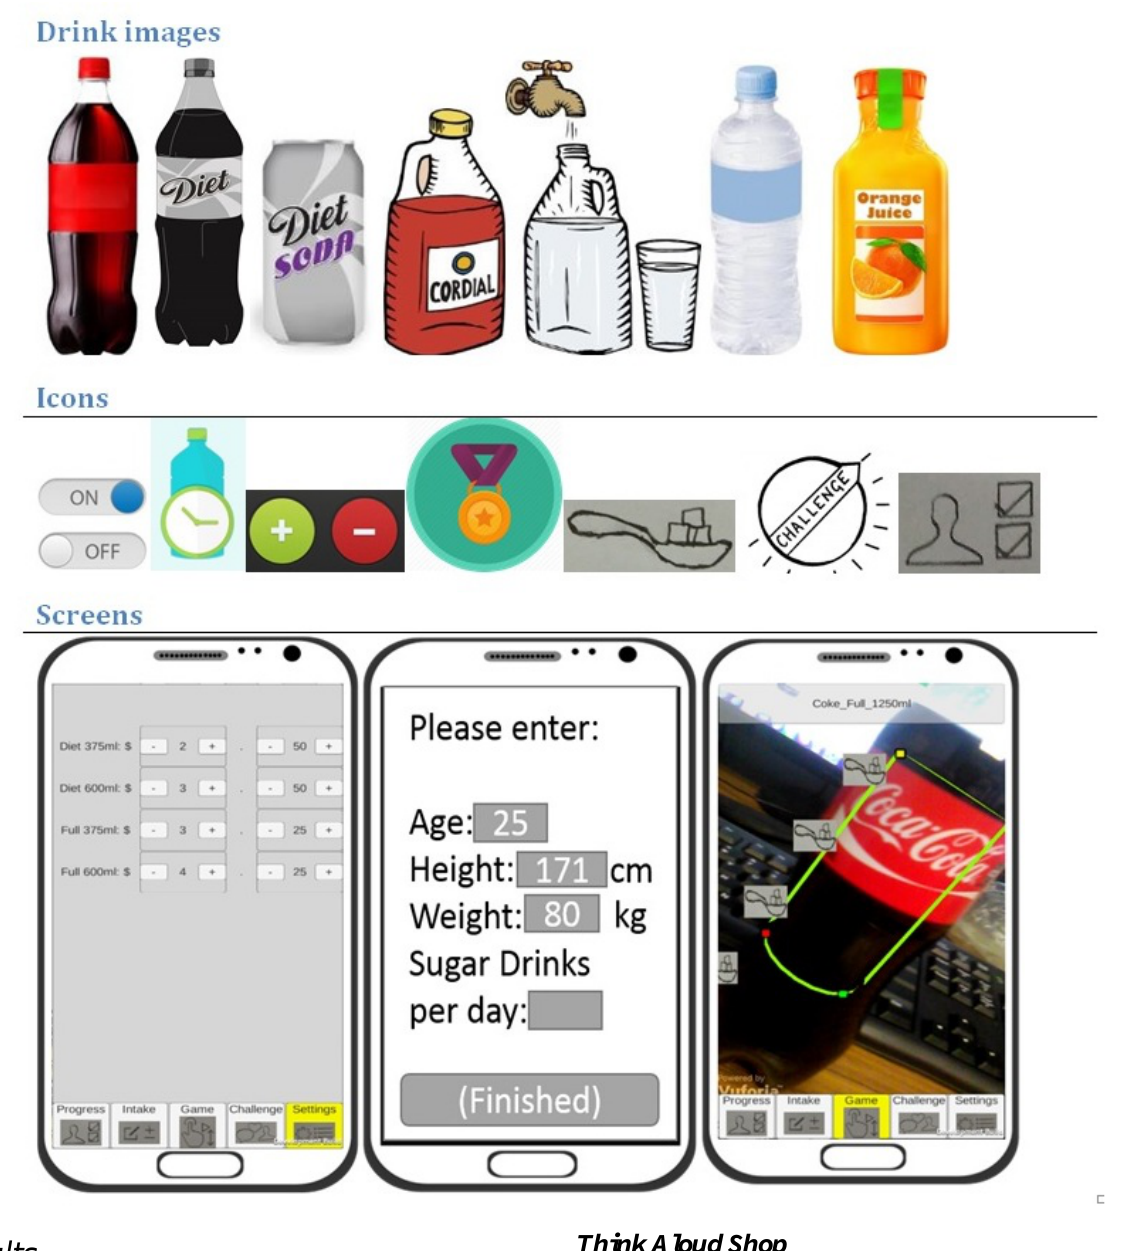
Figure 1. Example trigger materials for paper prototyping